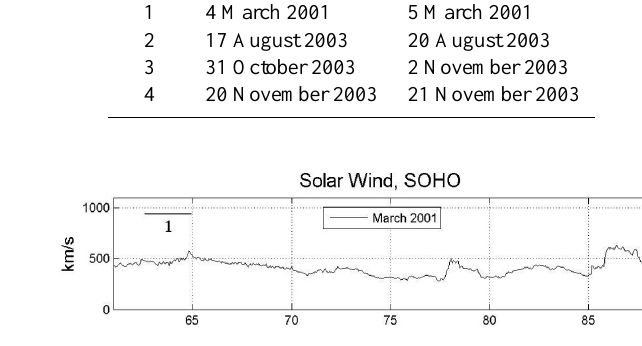
Fig. 1. Three time series of interplanetary magnetic field for months shown in legends. The CME events are indicated by a number and a short bar.